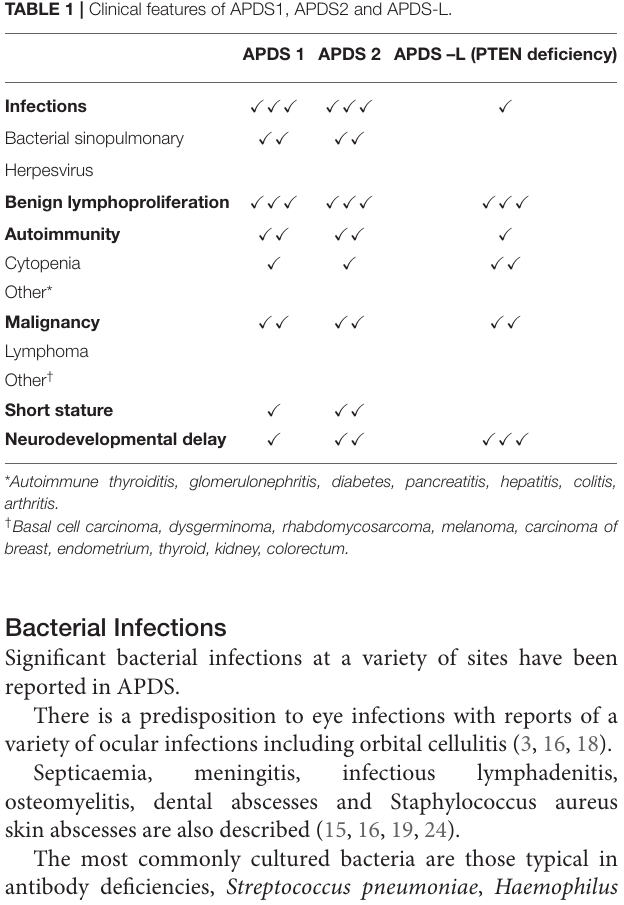
TABLE 1 | Clinical features of APDS1, APDS2 and